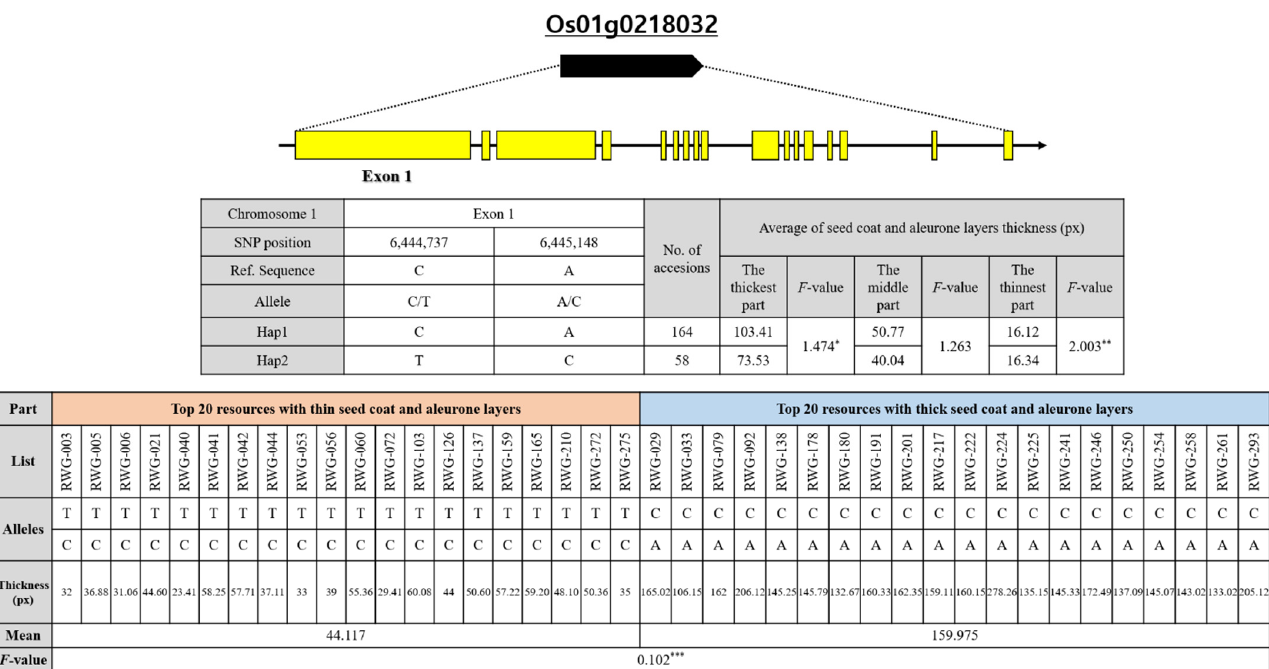
Figure 6. Manhattan plot derived from a GWAS scan for a traits of seed coat and aleurone layer thickness, thick aleurone 2 (TA2) gene structure, and its SNP location.